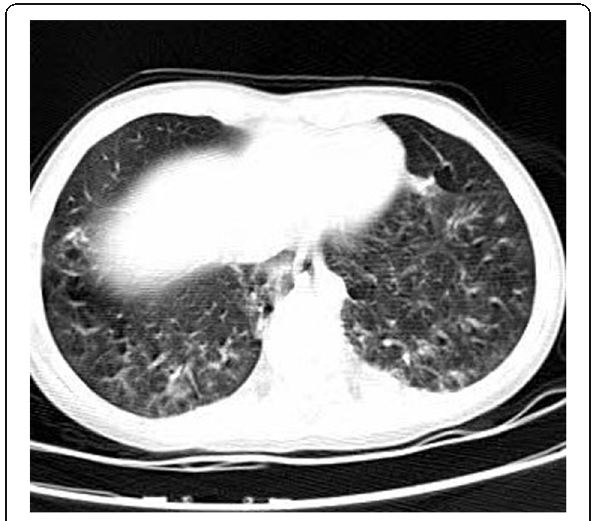
Fig. 3 Interlobular septal thickening and reticular density in both lower lobes and right-sided pleural